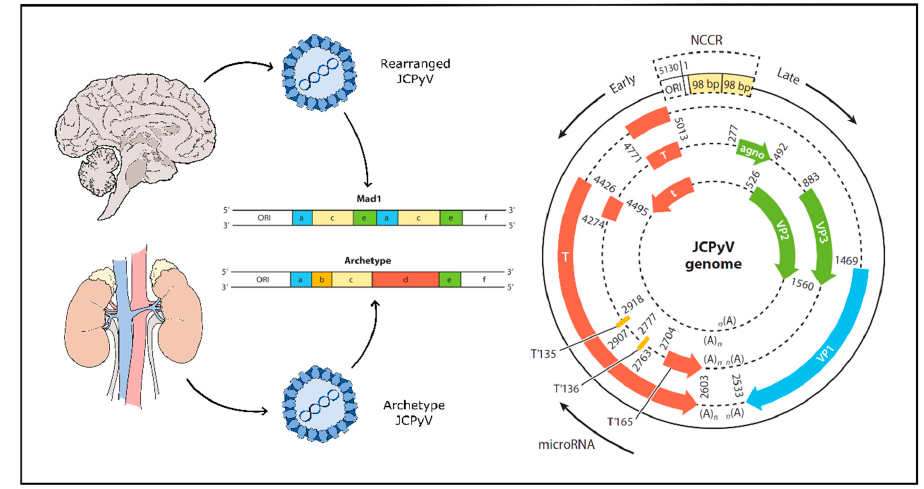
Figure 1. JCPyV genome undergoes rearrangement in progressive multifocal leukoencephalopathy (PML). Left panel: Archetype JCPyV develops a persistent infection in the kidneys and is generally